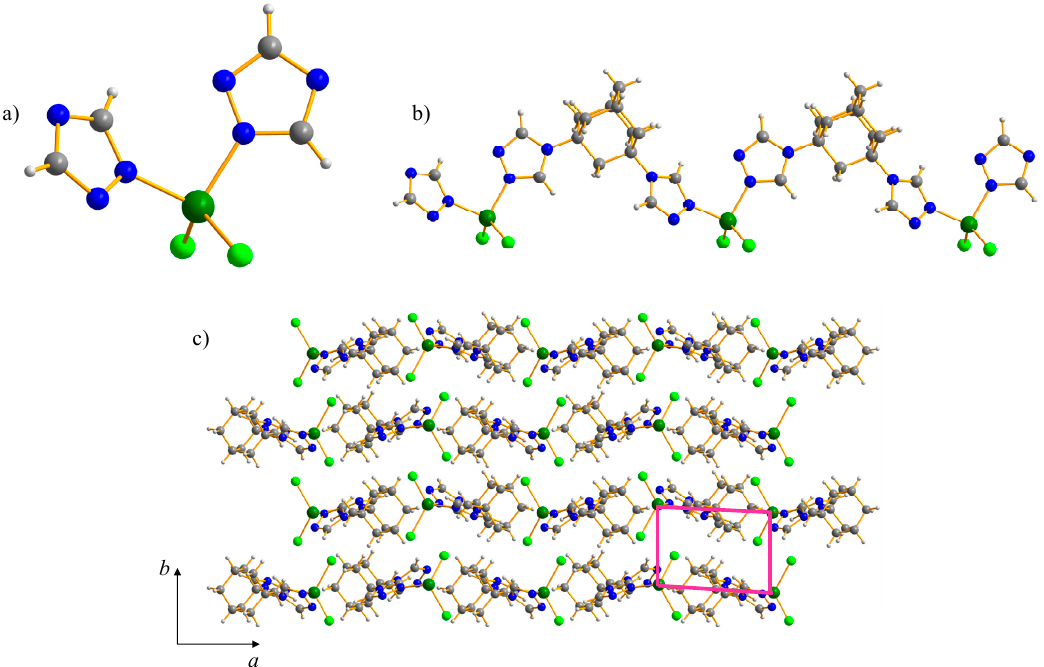
Figure 4. Representation of the crystal structure of [Zn(tr 2 ad)Cl 2 ] n : ( a ) the coordination sphere of the Zn II ions; ( b ) portion of the 1-D polymeric motif running along the [001] crystallographic direction; ( c ) portion of the packing, viewed along the [001] crystallographic direction. Horizontal axis, a ; Vertical axis, b . Highlighted in fuchsia the rectangular packing of the 1-D chains. Atoms colour code: C, grey; H, light grey; Cl, light green; N, blue; Zn, green. Main bond distances (Å) and angles (°) at the metal ions: Zn–Cl 2.153(7), 2.316(7); Zn–N 1.944(9), 2.01(1); shortest intra-chain Zn ∙∙∙ Zn 11.120(3);